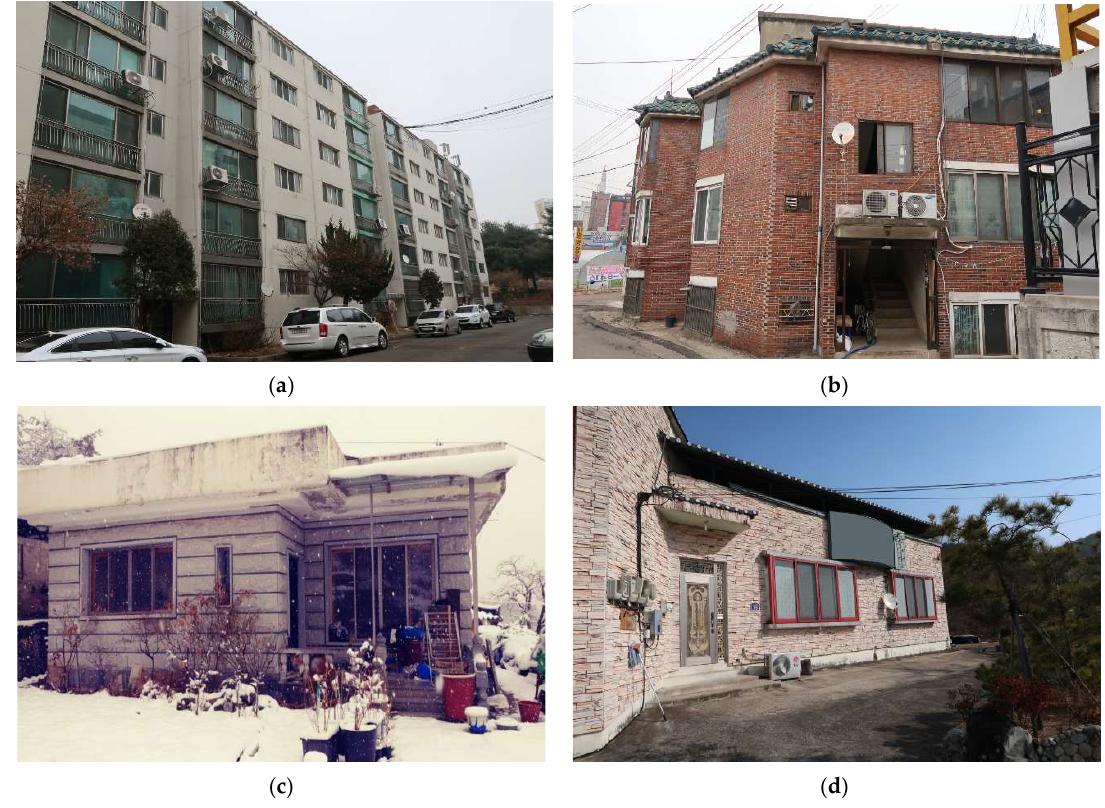
Figure 3. The target buildings: ( a ) Case A; ( b ) Case B; ( c ) Case C; ( d ) Case D.